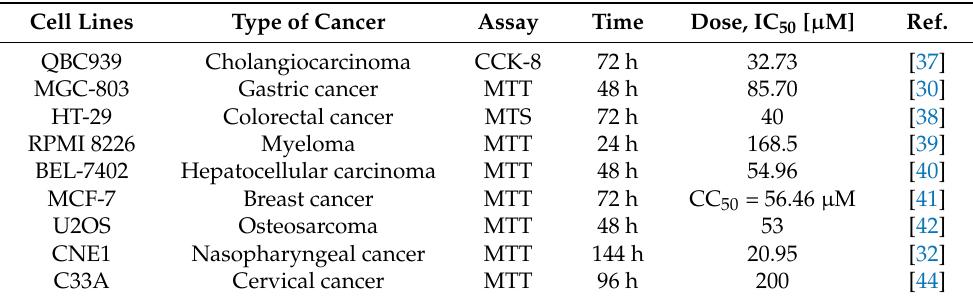
Table 1. In vitro studies demonstrating half maximal inhibitory concentration values of baicalein against several types of